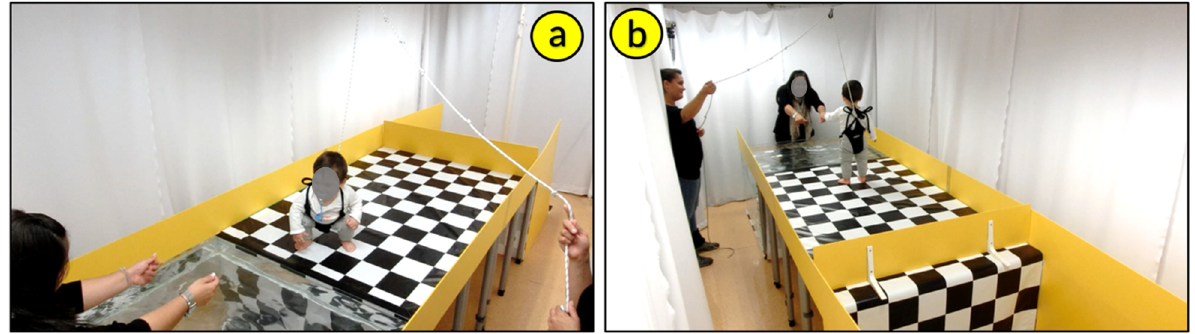
Figure 1. Real Cliff/Water Cliff apparatus synchronized cameras’ view. ( a ) water cliff camera front view and ( b ) water cliff camera back view. Photo reproduced with permission of the infant’s mother.